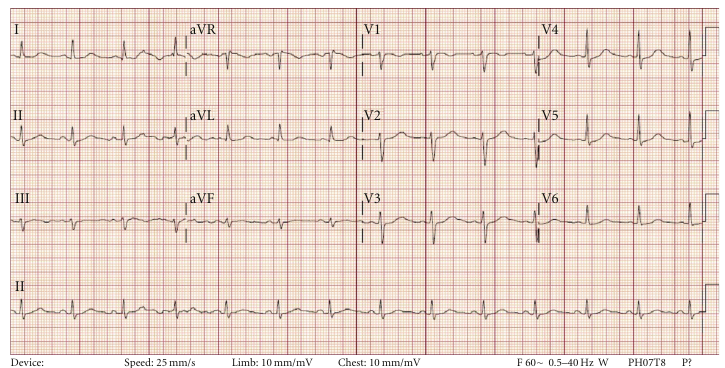
Figure 1: Baseline EKG was acquired about 14 months prior to the syncope episodes. QTc 455 ms.